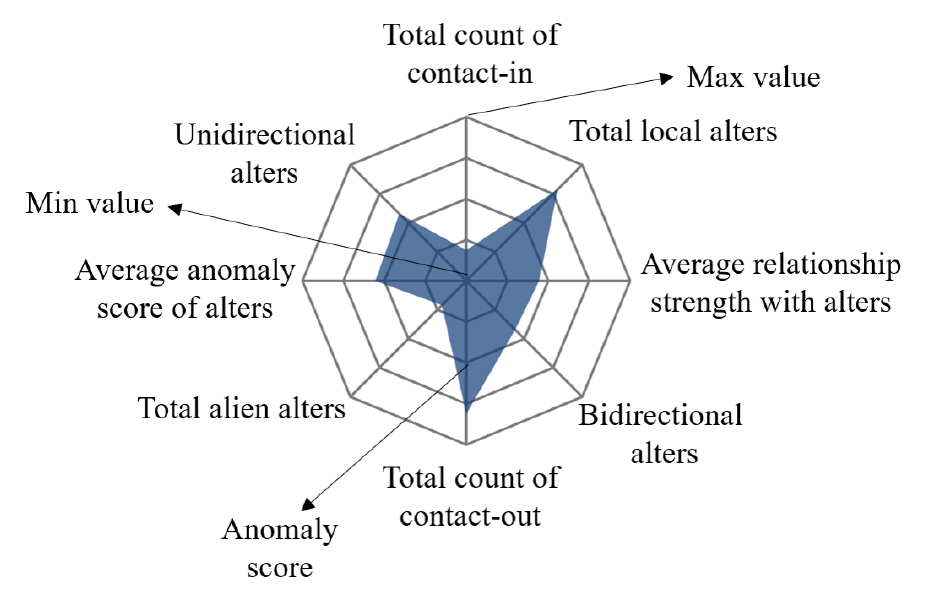
Figure 6. Ego features radar view with six